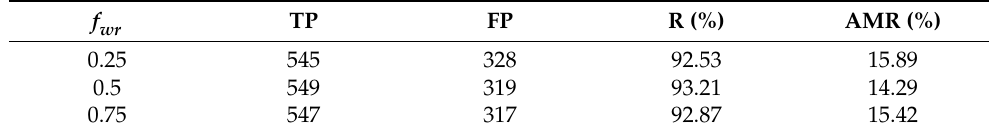
Table 4. Comparison of different f wr values in the integrated detector.